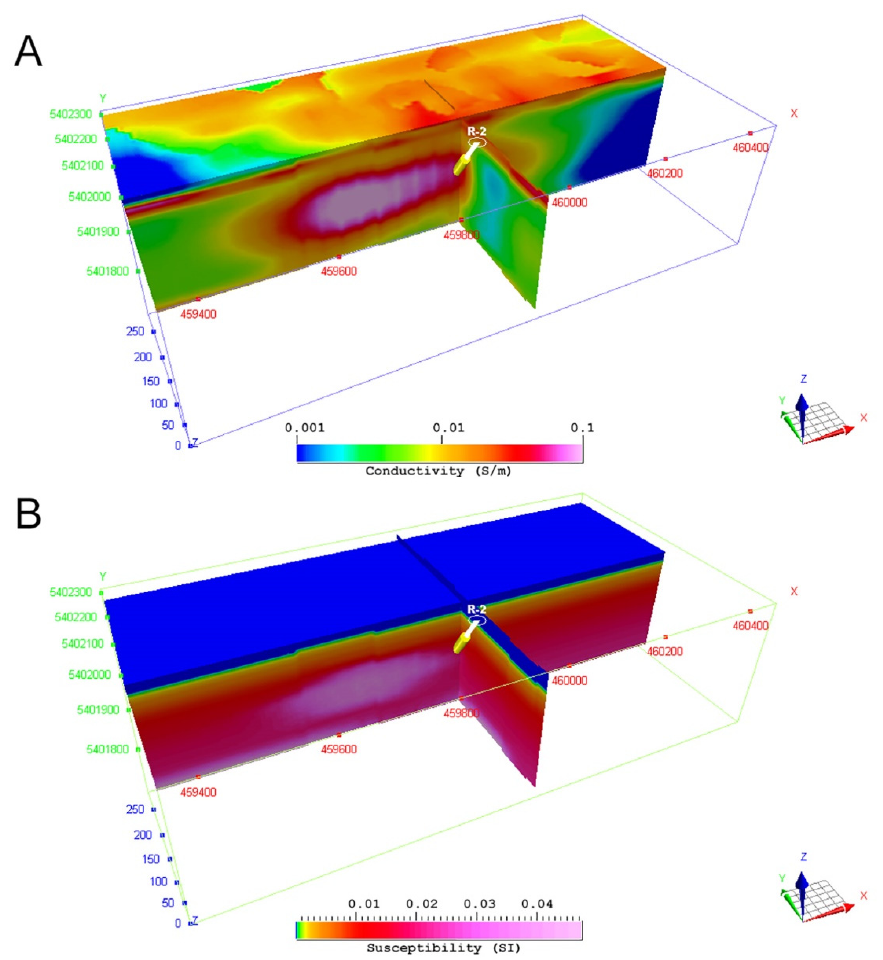
Figure 4. The Reid-Mahaffy test site. Panel ( A ) shows the 3D conductivity (S/m) model produced from standalone inversion. Panel ( B ) presents the 3D susceptibility (SI) model produced from standalone inversion. The red arrow is easting, and the green arrow is northing. The location of the borehole is shown by short white line. The yellow cylinder on the borehole indicates the confirmed zone of mineralization.